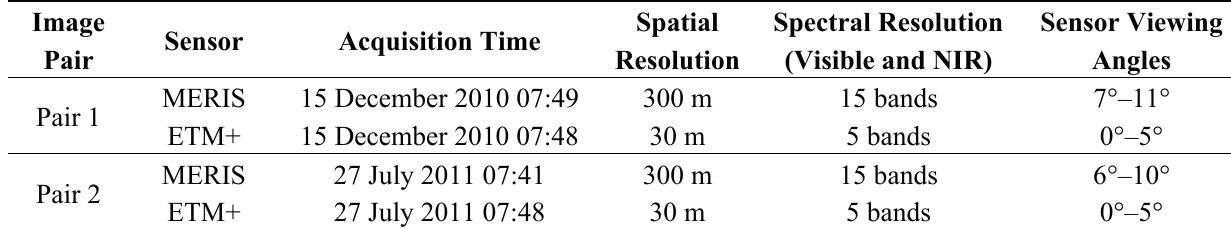
Table 1. A summary of satellite data used in the